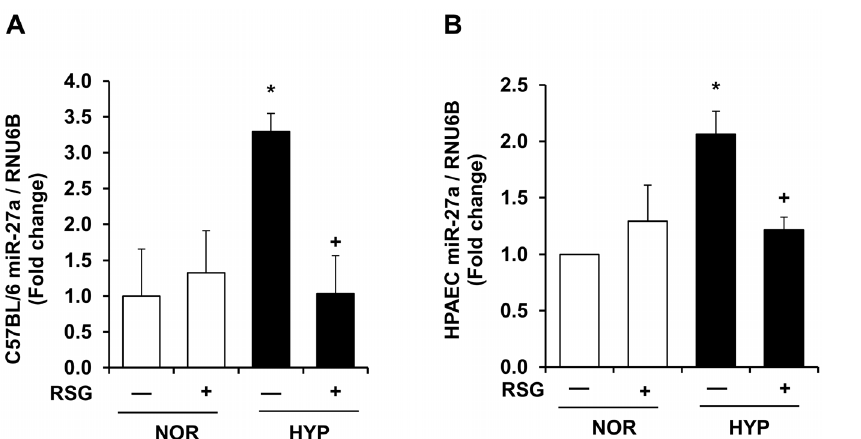
Figure 6. A PPAR c ligand attenuates hypoxic increases in miR-27a levels in mouse lung or in HPAECs. A. Whole lung homogenates were collected from mice exposed to normoxia (NOR, 21% O 2 ) or hypoxia (HYP, 10% O 2 ) for 3-weeks. During the last 10-days of this exposure, selected animals were also treated 6 rosiglitazone (RSG, 10 mg/kg/d by gavage) as we have reported. [12] Lung miR-27a levels were measured with qRT-PCR and are expressed relative to lung RNU6B. *p , 0.05 vs. NOR, + p , 0.05 vs. HYP, n=3–4. B. HPAECs were exposed to NOR (21% O 2 ) or HYP (1% O 2 ) for 72 h . Selected cells were treated during the final 24 h of exposure with RSG (10 m M). Each bar represents the mean miR-27a level relative to RNU6B 6 SE. *p , 0.05 vs. NOR, + p , 0.05 vs. HYP, n=3–6.